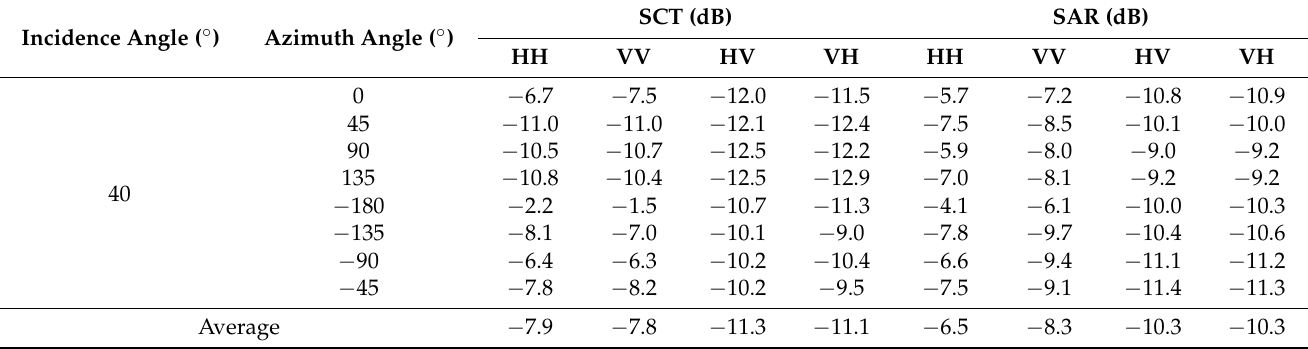
Table 5. Comparison of backscattering coefficients between scatterometric measurements and SAR images with azimuth angles ranging from 0 ◦ to 360 ◦ at the Ku band and an incidence angle of 40 ◦